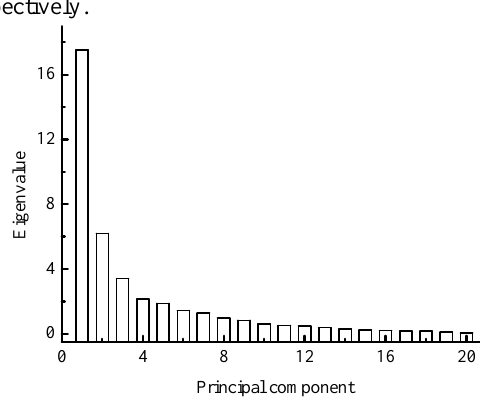
Fig. 5 The first twenty eigenvalues of covariance matrix The location includes the recognition of crack region and the prediction of distance from crack source to welding seam. There are six output units for the two testing blades (see table 1). The first unit represents the status of blade 1. The second unit represents the status of blade 2. The third, fourth, fifth unit represent the status of blade regions Z1, Z2, Z3, respectively. And the last one represents the distance from crack source to welding seam normalized by min .The − max min output value of the first five units is 1 or 0 (1 represents “with crack”, 0 represents “without crack”) and that of unit 6 is any value between 0 and 1. In order to recognize the result conveniently, the outputs of blade and crack region were dealt with competing mode, respectively, that was, only maximum value was set to 1 and the else is set to 0. which is because the transmission speed of AE signal in parameters from different blade regions is small. In addition, the results based on KICA feature parameters are better than those based on ICA due to good quality of data input after nonlinear feature extraction. For the prediction distances from AE sources to welding seam, the mean square error (MSE) of WNN is less than that of BPNN. The minimum MSE is also obtained by nine KICA feature parameters, followed by five KICA feature parameters. The worst one is from the five original parameters. Likewise, the prediction distance of WNN with nine KICA feature parameters